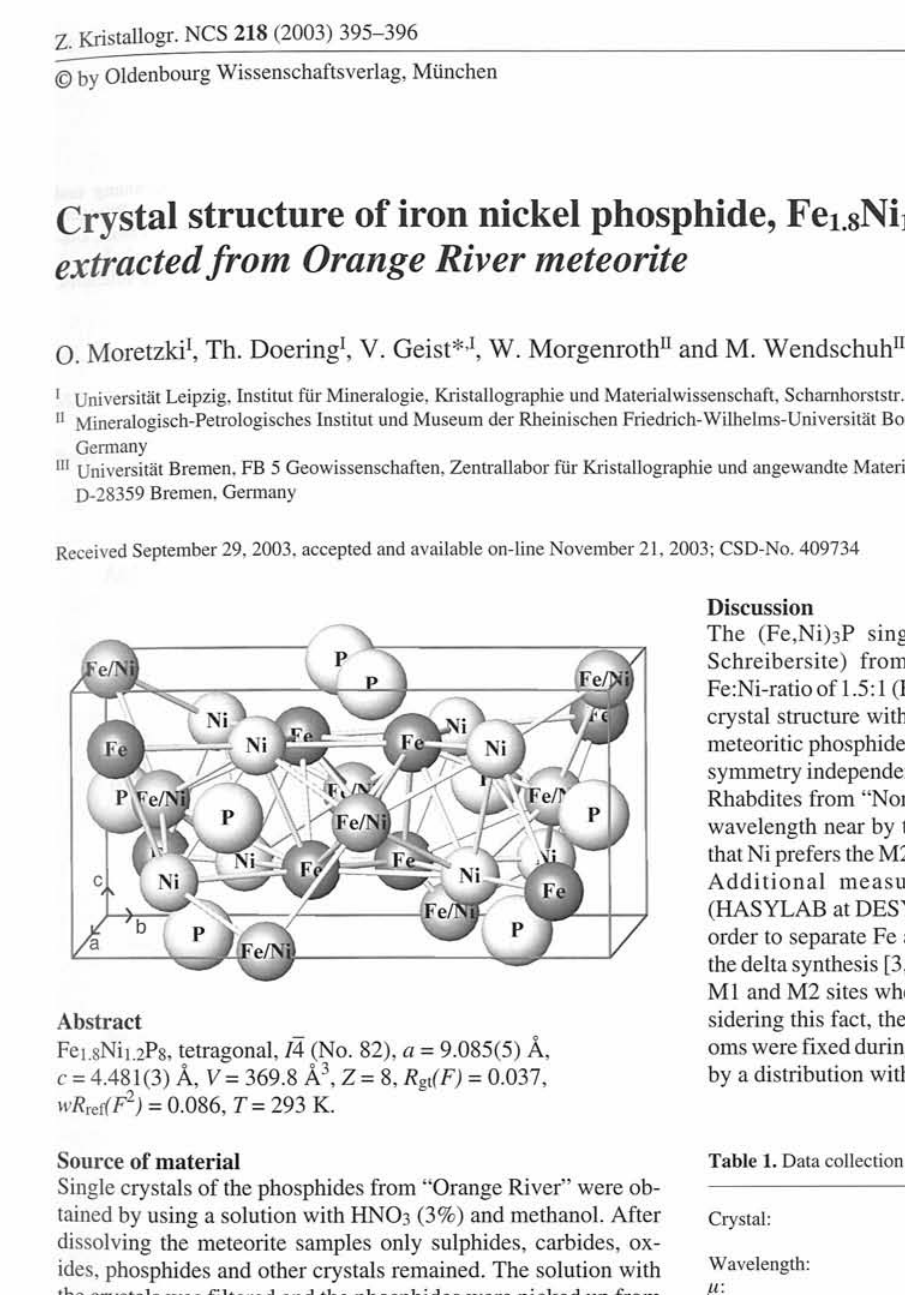
Table 2. Atomic coordinates and displacement parameters (in Â 2 ).